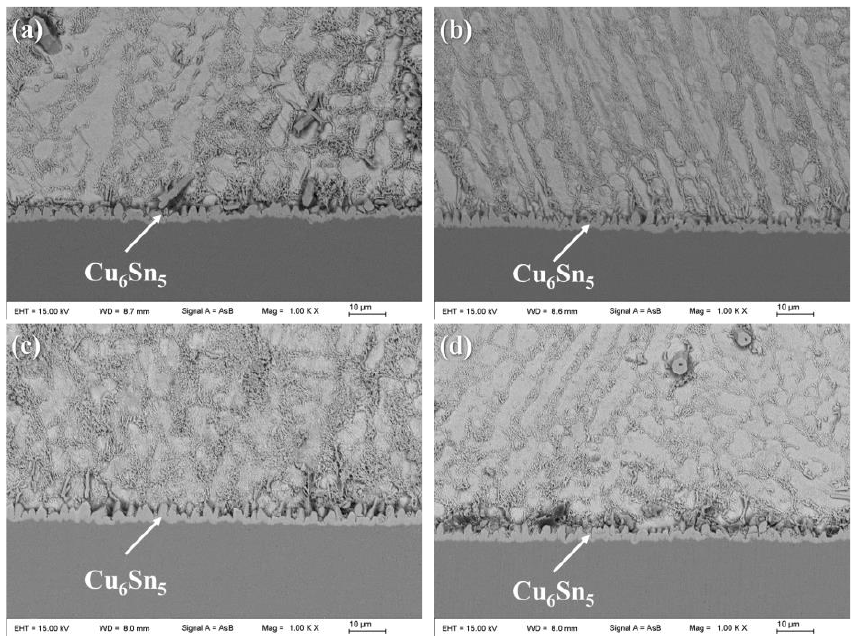
Figure 8. Interfacial morphologies of plain SAC305 and SAC305-ER solder joints: ( a ) plain SAC305, ( b ) x = 4 wt %, ( c ) x = 8 wt %, ( d ) x = 12 wt %.